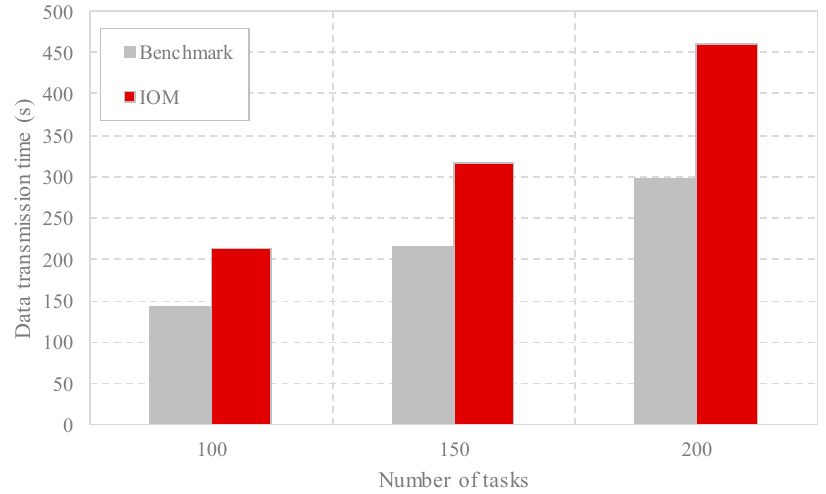
Figure 5. Comparison of the average resource utilization of the cloudlets with different task scales by Benchmark and IOM.